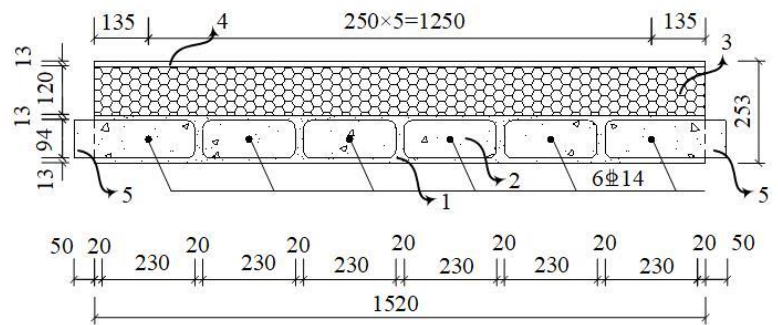
Figure 1. Plan view. Notes: 1. gypsum cavities; 2. concrete dense-column; 3. polystyrene insulation board; 4. gypsum protection board; 5. Loading position.